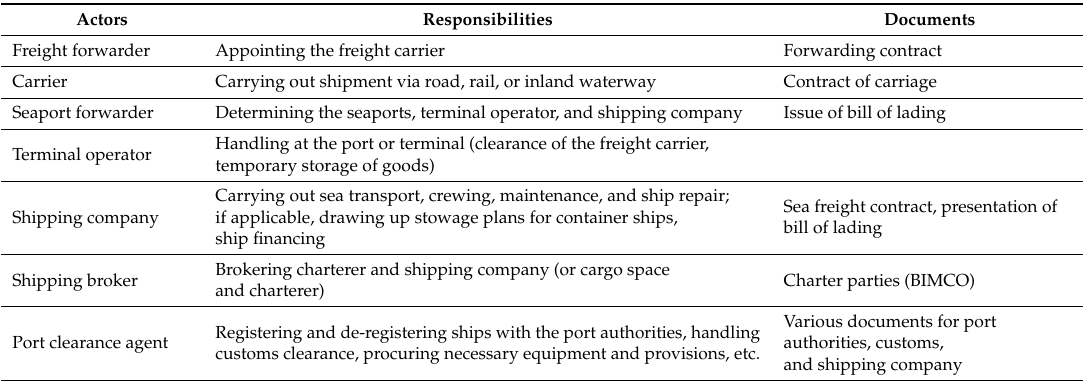
Table 5. Actors in maritime freight transportation